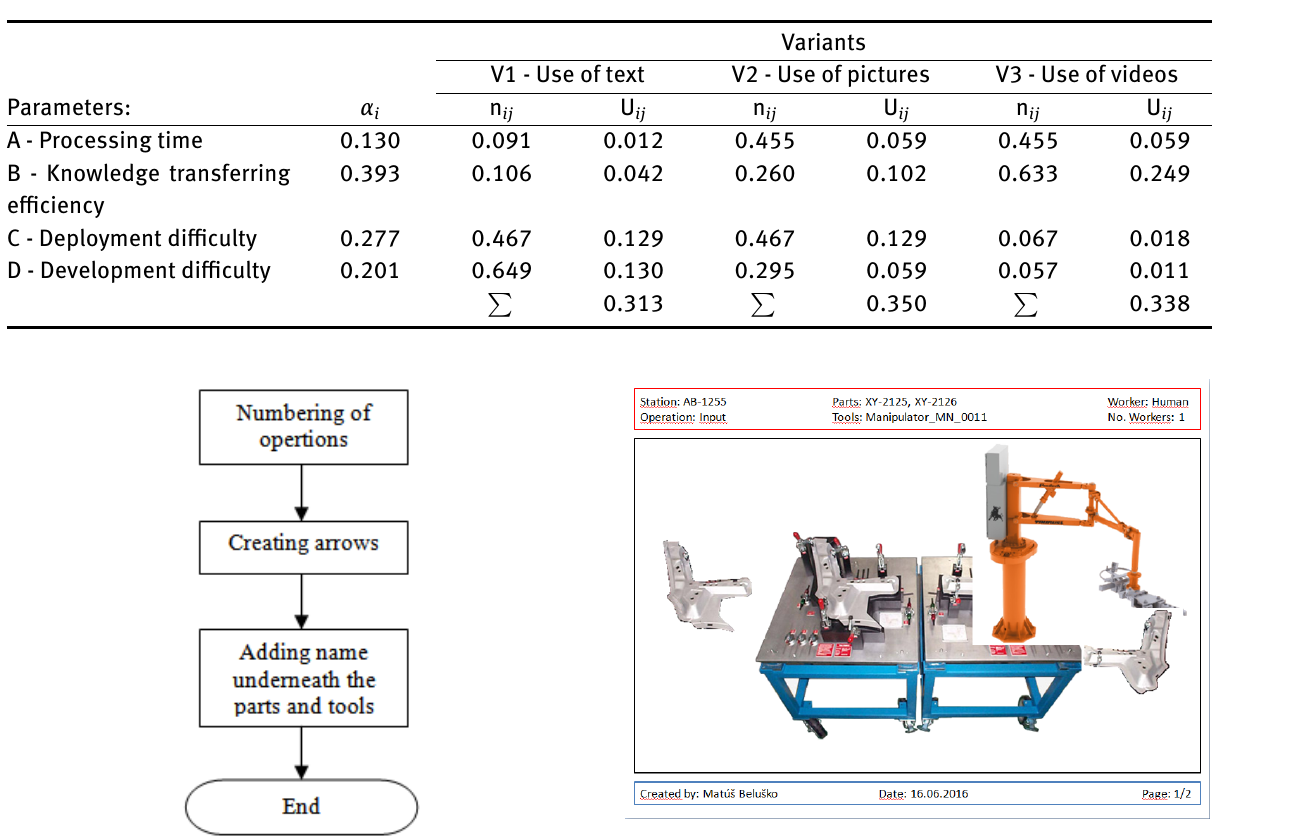
Table 13: Final result of Saaty’s decision method.